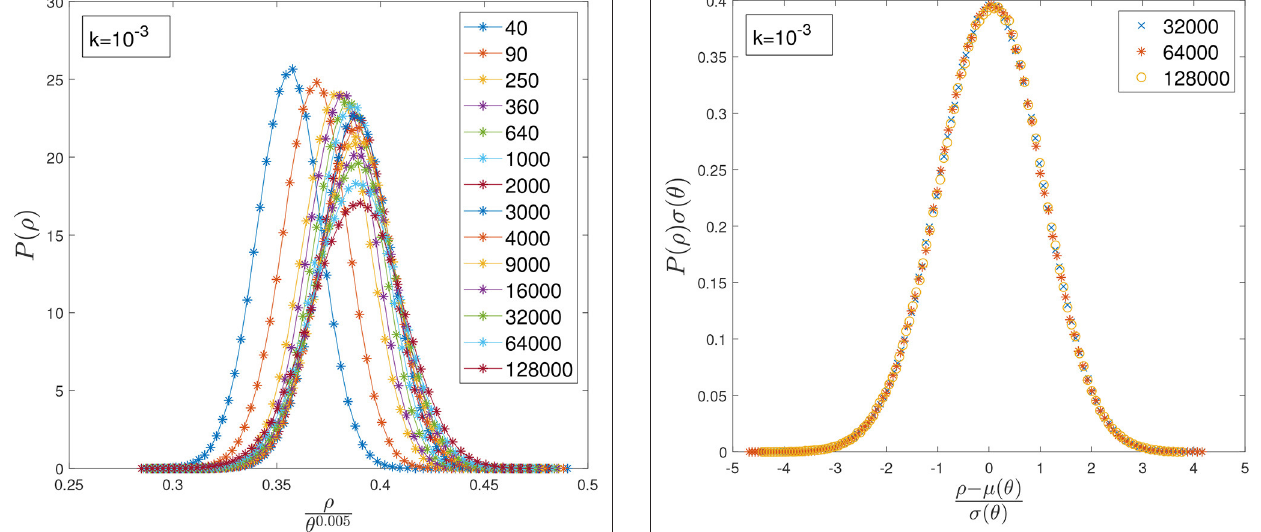
Using these estimates, we find that a data collapse seems to hold well for very large values of θ , as can be seen in Figure 6